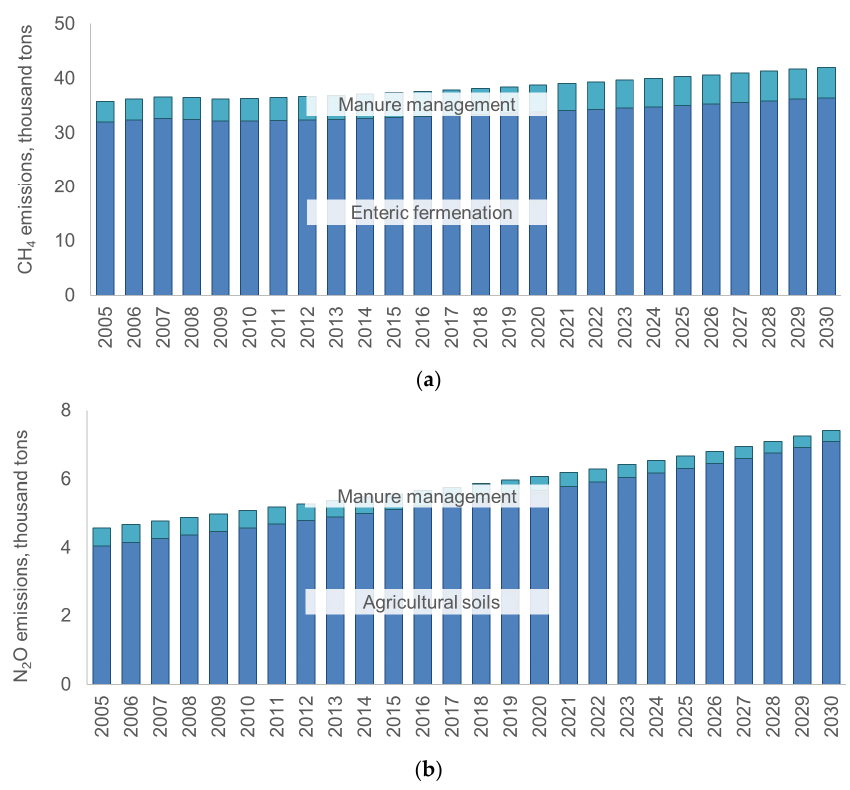
Figure 8. Annual ( a ) methane and ( b ) nitrous oxide emissions from the agriculture sector in Latvia, 2005–2030 (data from Dace et al. [2]).